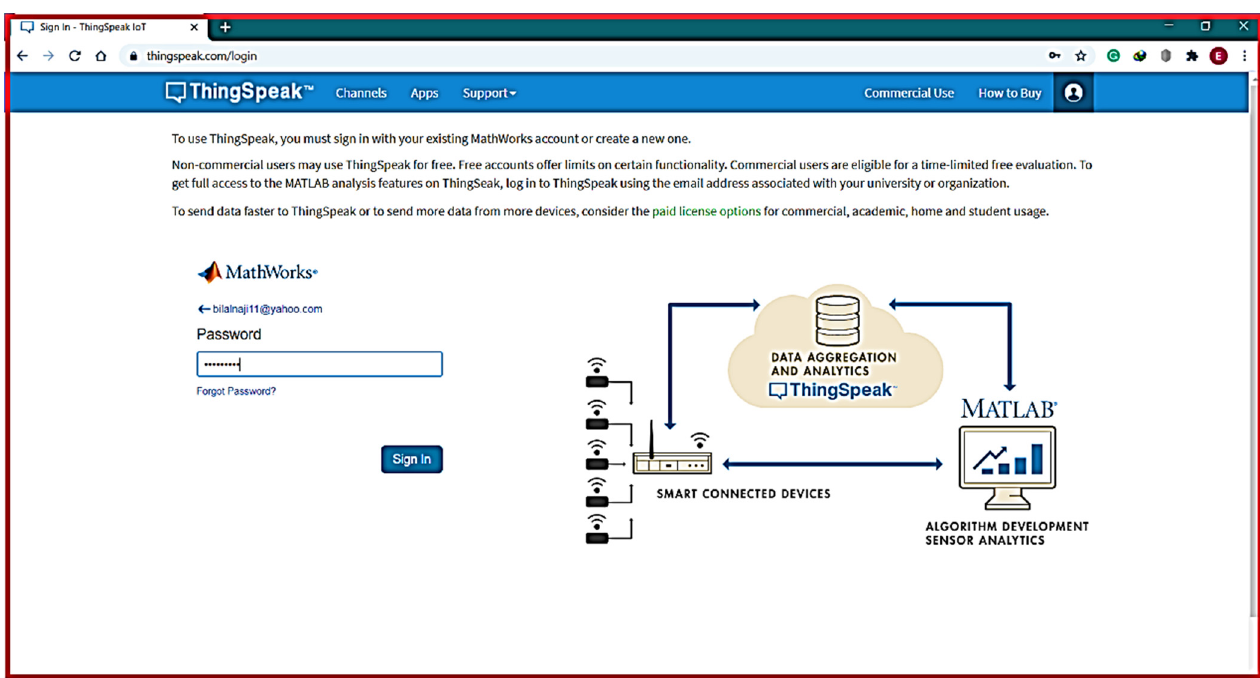
Figure 8. ThingSpeak platform.